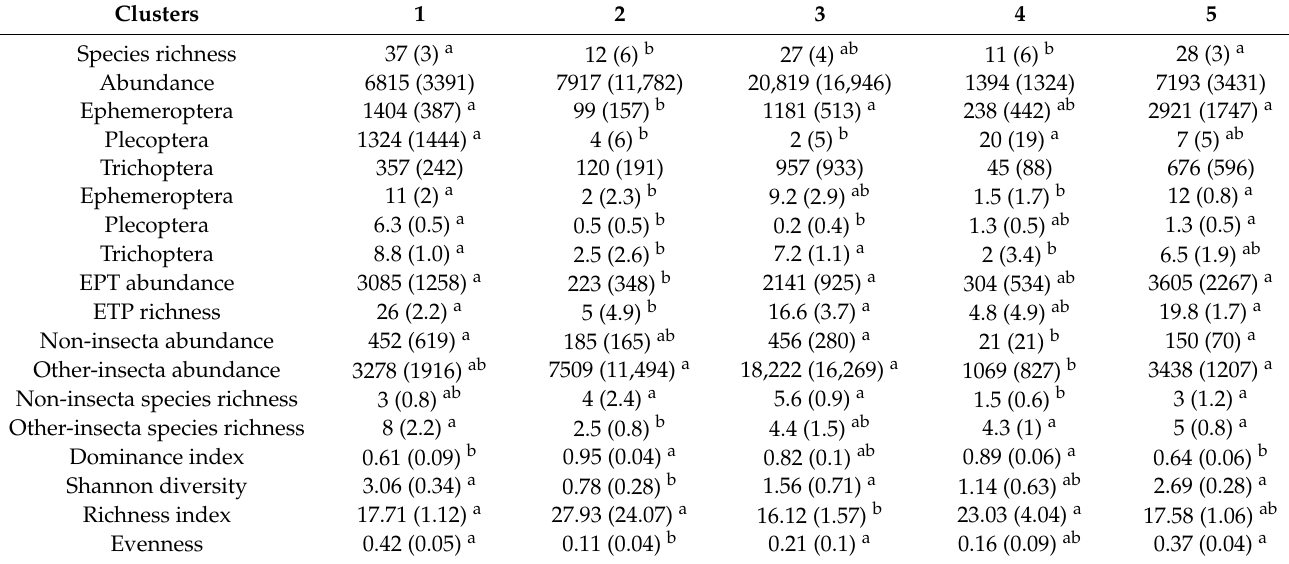
Table 2. Differences in community indices between five clusters in a self-organizing map.